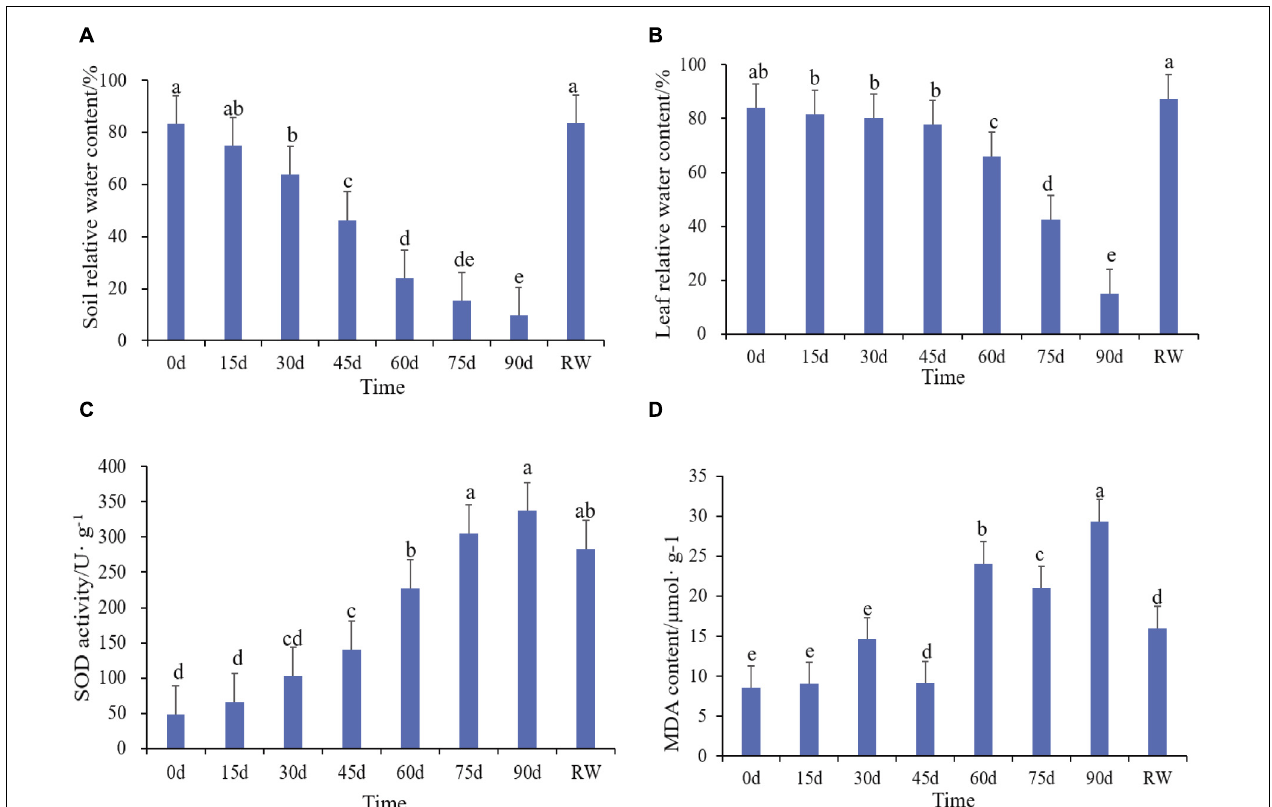
FIGURE 2 | Physiological and biochemical changes of Rosa chinensis ‘Old Blush’ under drought and rewatering treatment. (A) Soil relative water content. (B) Leaf relative water content. (C) MDA content. (D) SOD